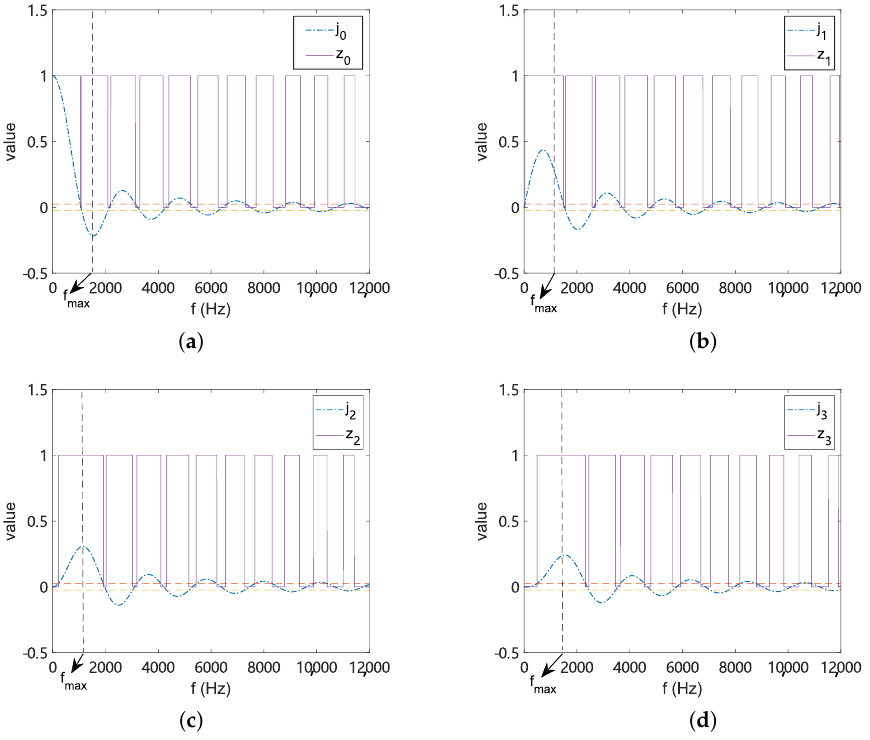
Figure 1. The spherical Bessel function j n ( 2 π f R Q / c ) and ˆ Z n ( f ) of order ( a ) n = 0, ( b ) n = 1, ( c ) n = 2, ( d ) n = 3 with f max ≈ 1360 Hz, (cid:101) = 1/40, R Q = 0.16 m and c = 343